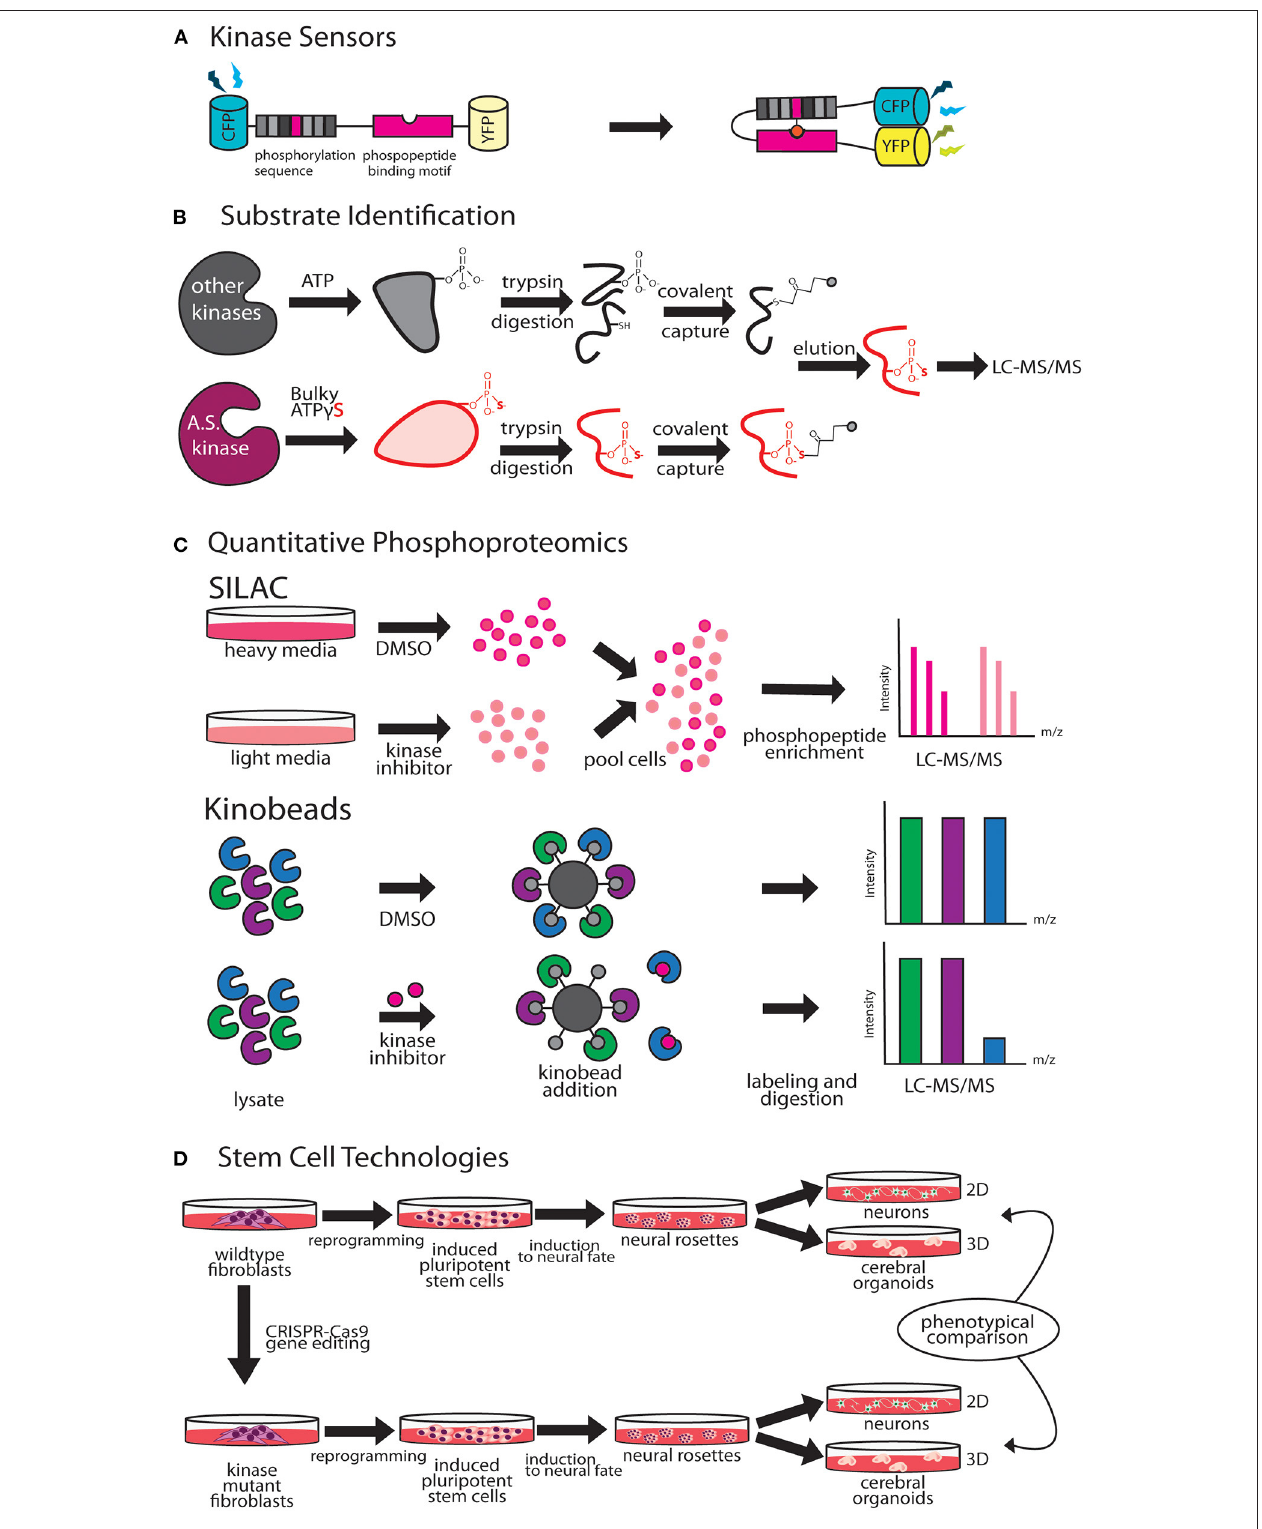
FIGURE 2 | Emergent technologies to investigate kinase pathways. (A) FRET-based kinase sensors are comprised of kinase specific phosphopeptide sequence and a phosphopeptide binding motif. (B) Analog-sensitive kinases are an important tool for direct substrate identification through covalent capture of phosphopeptides and mass spectrometry. (C) Stable isotope labeling of amino acids in culture (SILAC), is a versatile metabolic labeling proteomic technique that can be applied to study the effect of kinase inhibitors on neuronal growth by quantifying changes in proteome. Kino-beads can be employed for profiling the neuronal kinome in healthy and disease states. (D) Human iPSCs have been used to model neurological diseases associated with kinase genes.